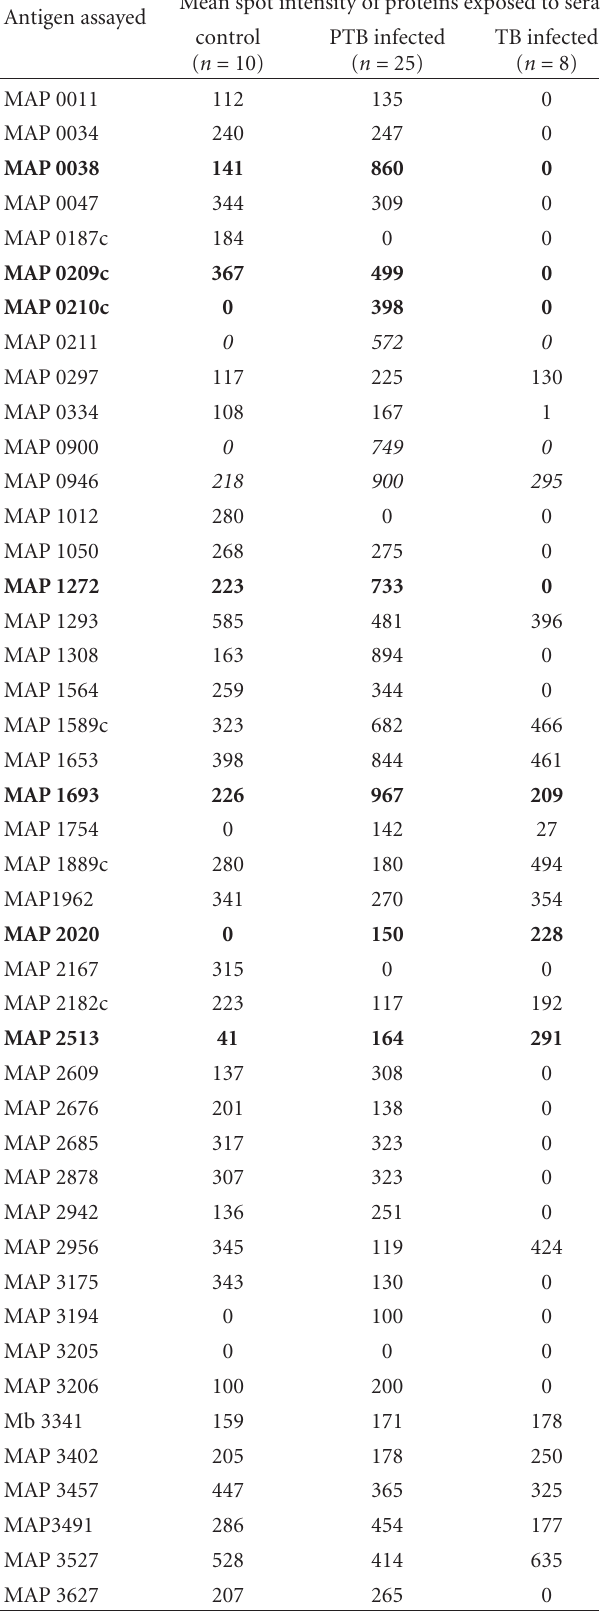
Table 2: Spot intensities for protein macroarrays. Antigen